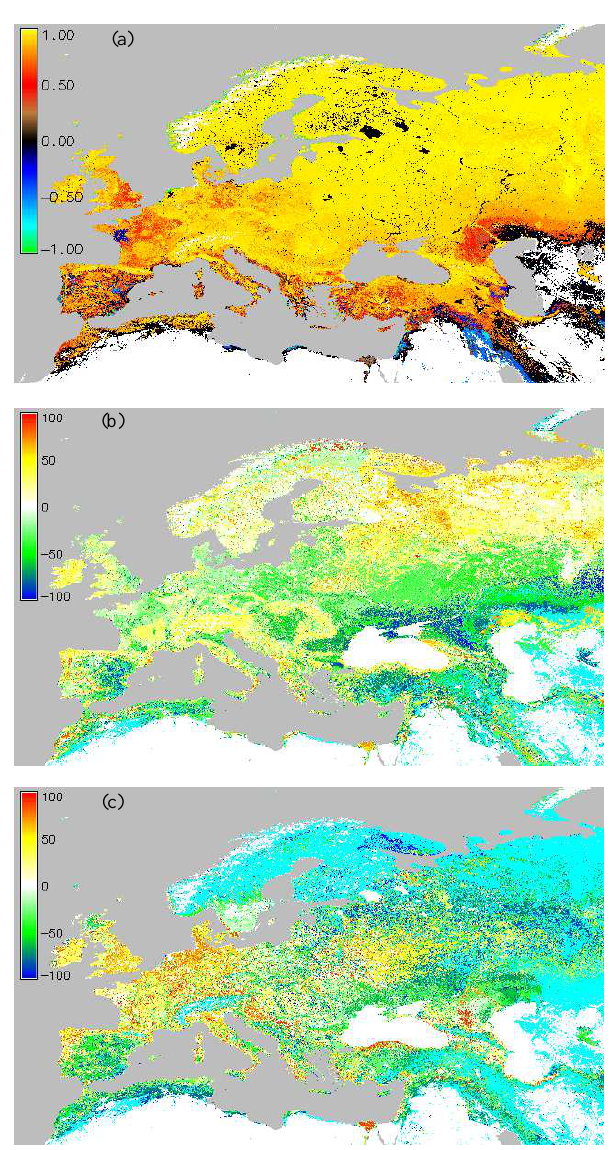
Figure 8. Comparison of ECOCLIMAP-II and ECOCLIMAP-I LAI: Pearson’s correlation Fig. 8. Comparison of ECOCLIMAP-II and ECOCLIMAP-I LAI: Pearson’s correlation coefficient (a) , normalized difference (%) of coefficient (a), normalized difference (%) of maximum LAI (b), and minimum LAI (c) where maximum LAI (b) , and minimum LAI (c) where the normalized the normalized difference is defined as the difference between ECOCLIMAP-II and difference is defined as the difference between ECOCLIMAP-II and ECOCLIMAP-I divided by the average of the two. ECOCLIMAP-I divided by the average of the